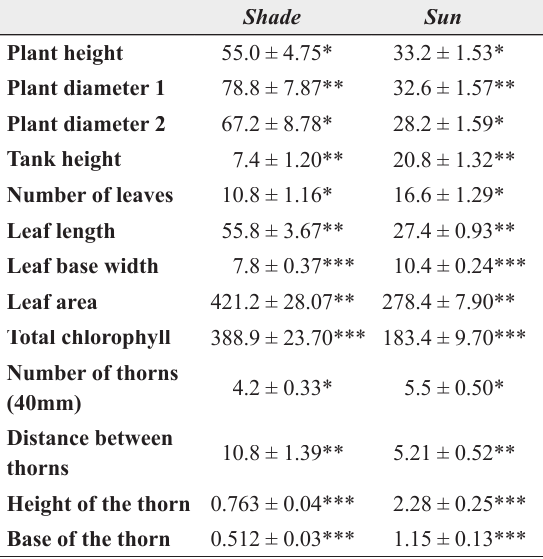
Morphological measurements of the rosettes and leaves of shade and sun plants of Neoregelia cruenta .